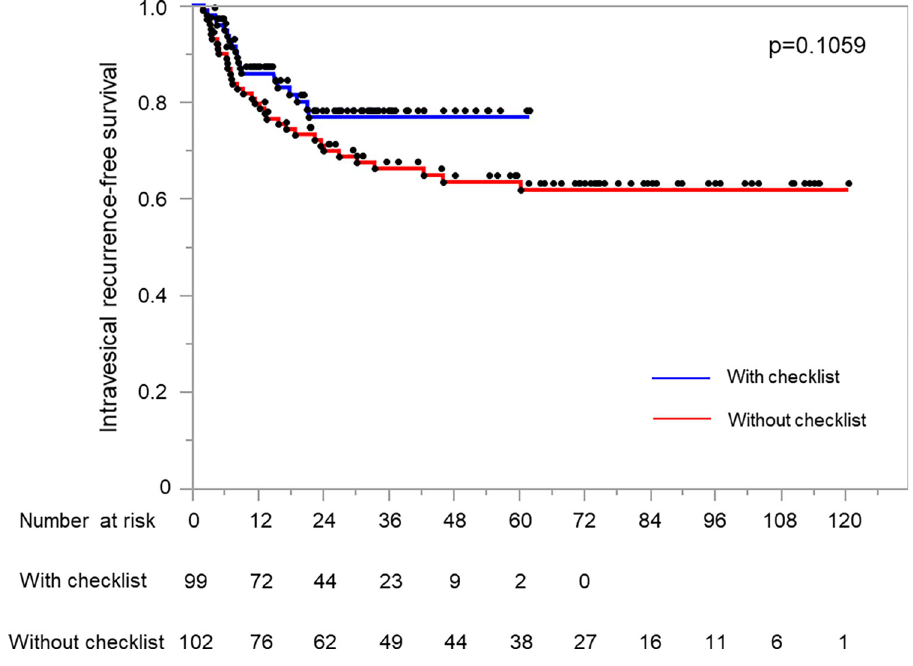
Fig 1. Kaplan–Meier curves of the intravesical recurrence-free survival rates for TURBT using with and without surgical checklist groups.